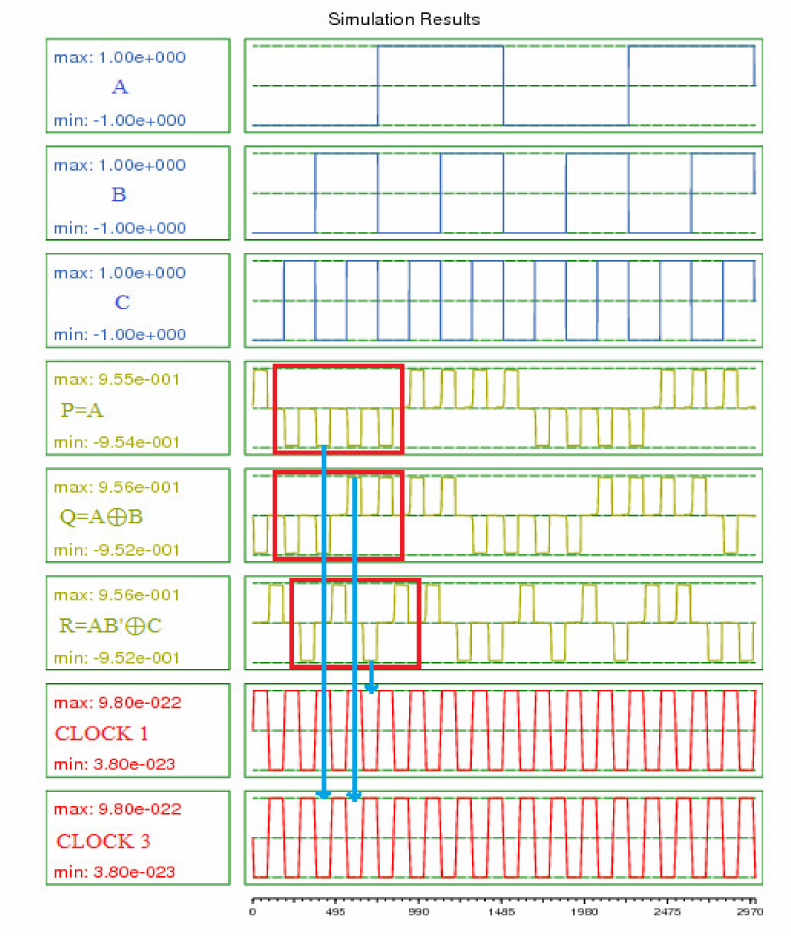
Figure 13. Simulation results for TR